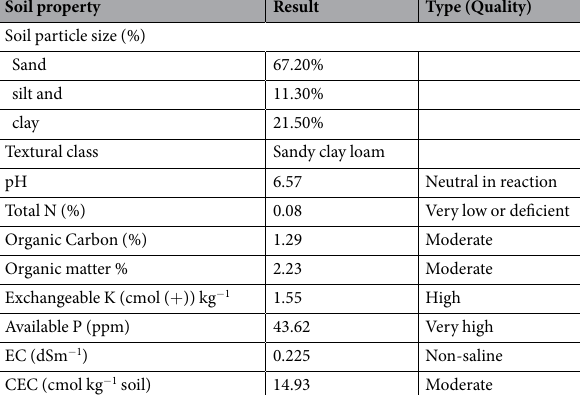
Nitrogen Rate (kg ha − 1 )